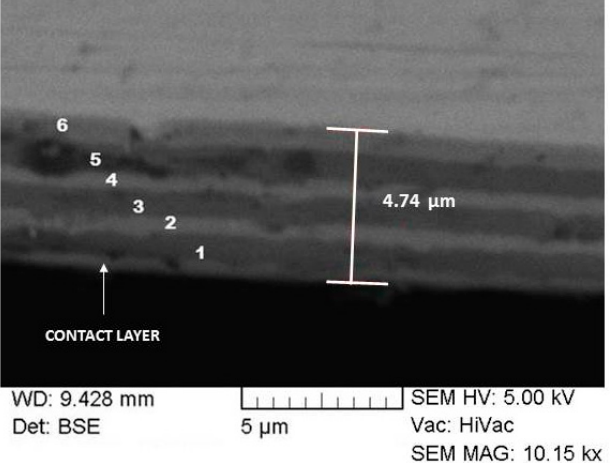
Figure 6. A SEM cross-section image of the compositionally modulated CrAlSiN–AlSiN coating. Table 1. Element composition of the modulated CrAlSiN–AlSiN and reference CrAlSiN and AlSiN coatings.